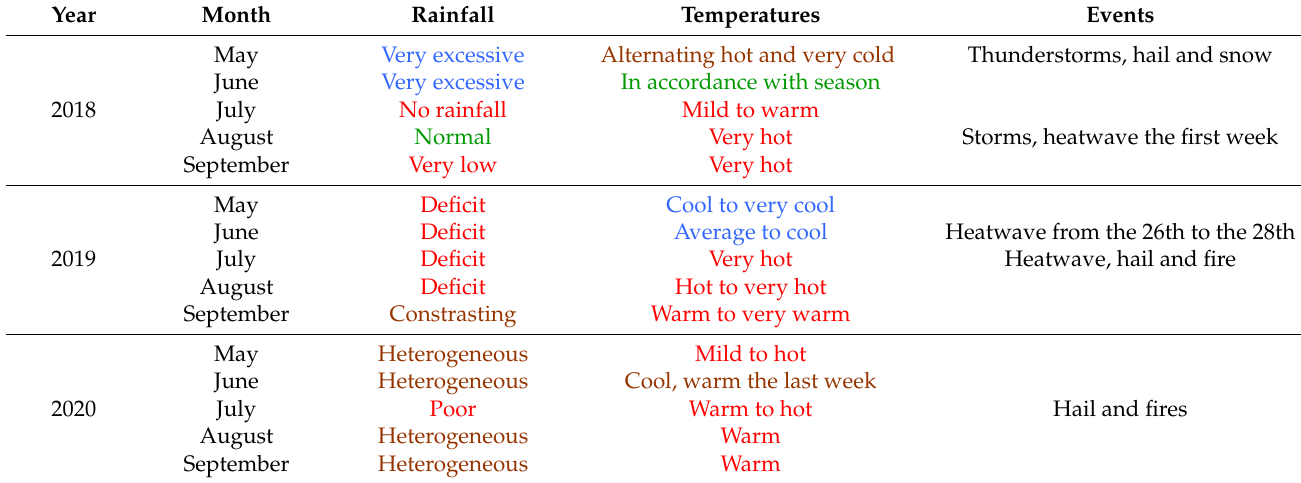
Table 1. Summary of the weather from May to September for 2018, 2019 and 2020 adapted from technical reports of Departmental Council of the Hérault region. Particularities are highlighted in red for a lack of water or warm temperatures, blue for too much water and cool temperatures, green for normal data and brown for contrasting rainfall or